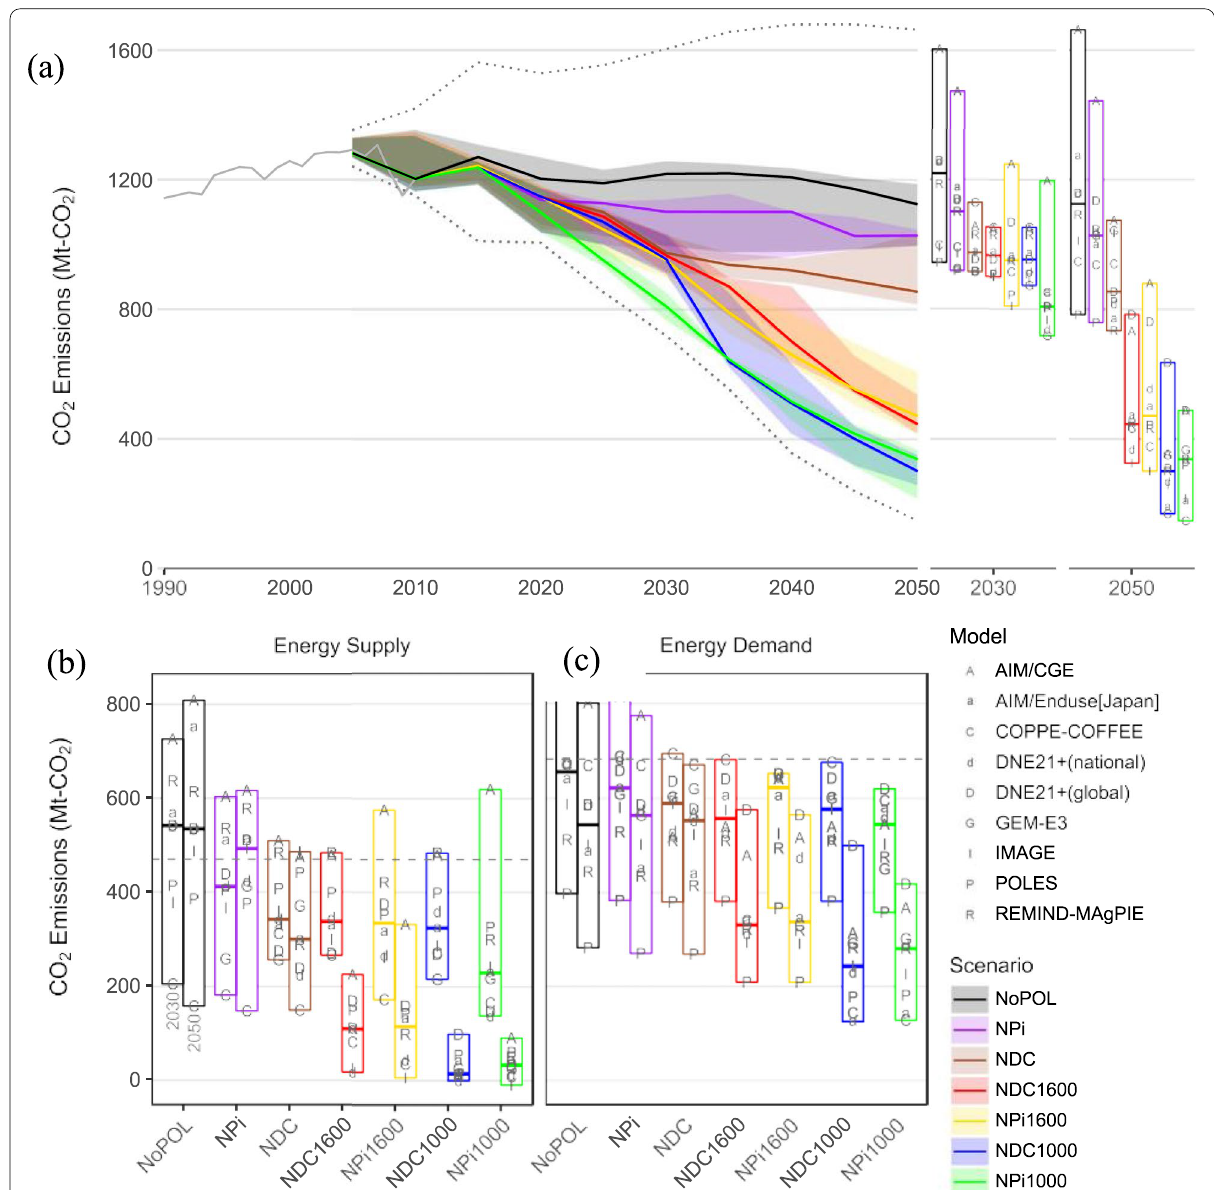
Fig. 9 Carbon neutrality simulation for Japan in 2010–2050: ( a ) Annual CO 2 emission from energy and industrial processes in various scenarios (Projected range of annual CO 2 emission for 2030 and 2050 shown on the right); Range of direct CO 2 emission in each scenario in ( b ) 2030 and ( c ) 2050 compared to 2010 (dashed line)